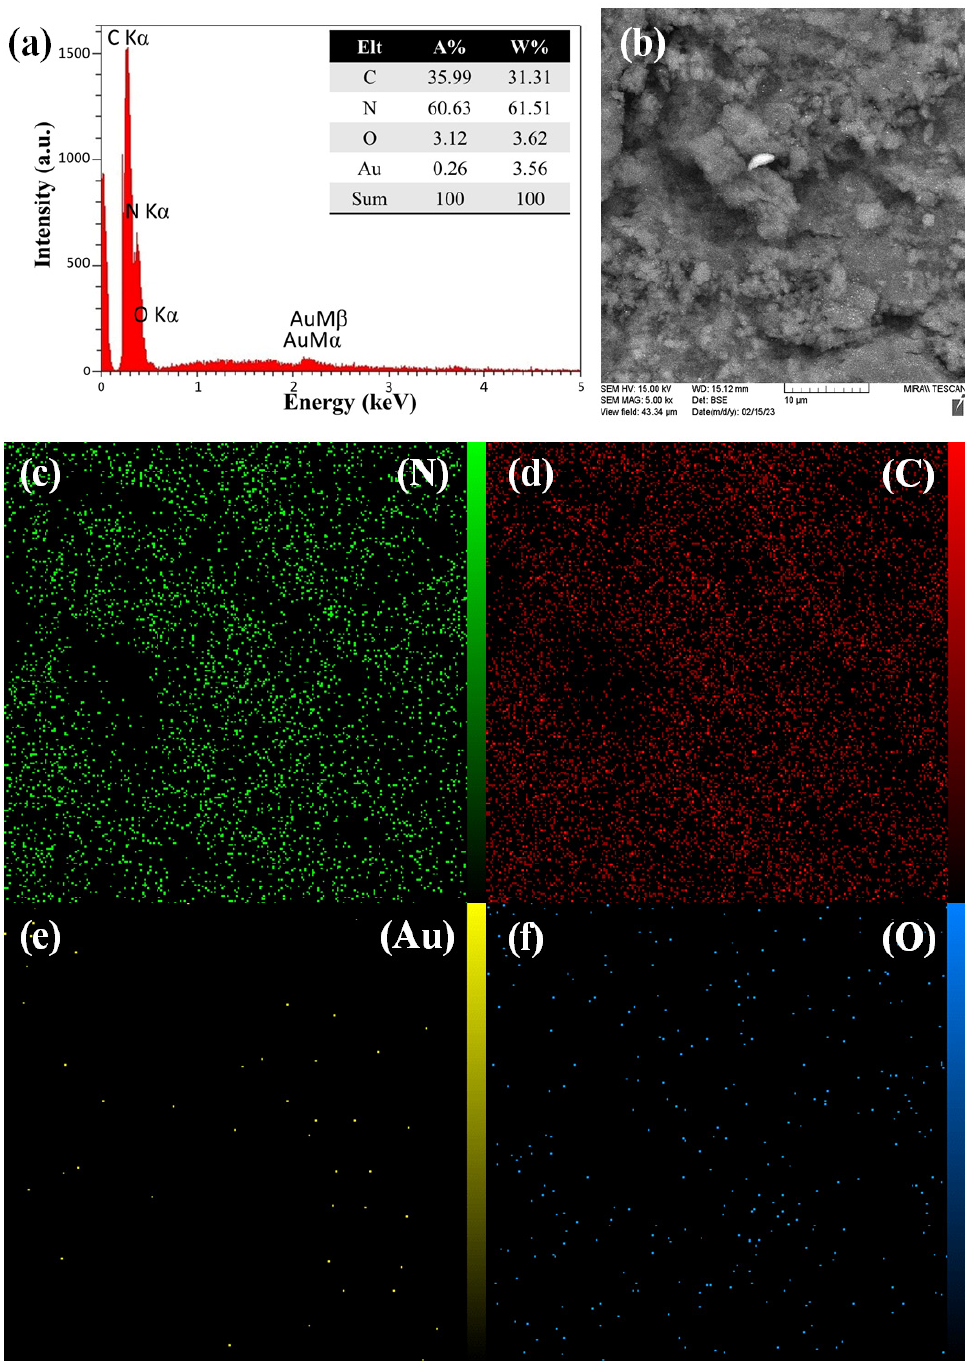
Figure 6. EDS pattern ( a ), representative EDS image ( b ), MAP of nitrogen element ( c ), MAP of carbon element ( d ), MAP of Au element ( e ), and MAP of oxygen element ( f ) of CNN/Au nanocomposite. The optical band gap of the semiconductors indicates the required energy of excita- tion and the transition of an electron from the valence to the conduction band. UV-Vis spectroscopy corresponds to the electron transition between the energy levels and for CNN and the CNN/Au nanomaterials, the spectra are shown in Figure 7a. As shown, two